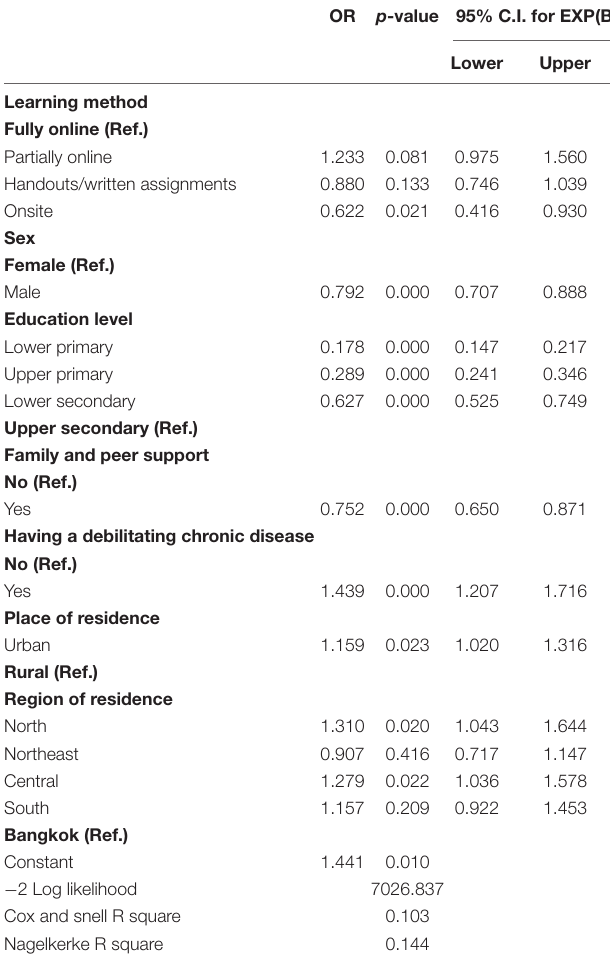
TABLE 3 | Correlates of school closure-induced anxiety at a moderate-to-severe level.